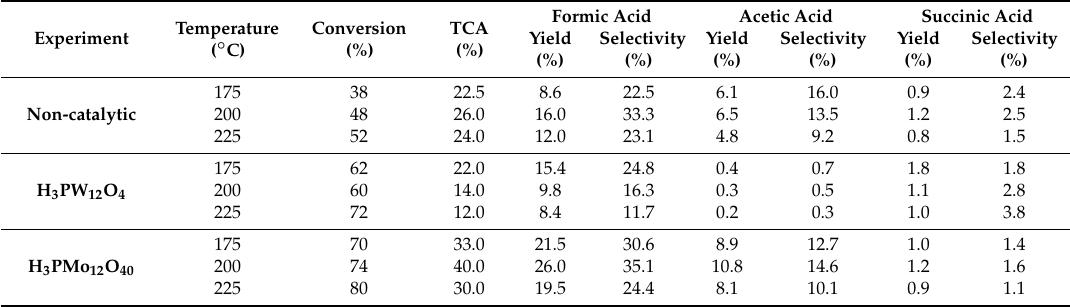
Table 1. Yields and selectivity of the main detected carboxylic acids at a reaction time of 60 min. The lignin to catalyst ratio was 2:1 ( w / w ) for both